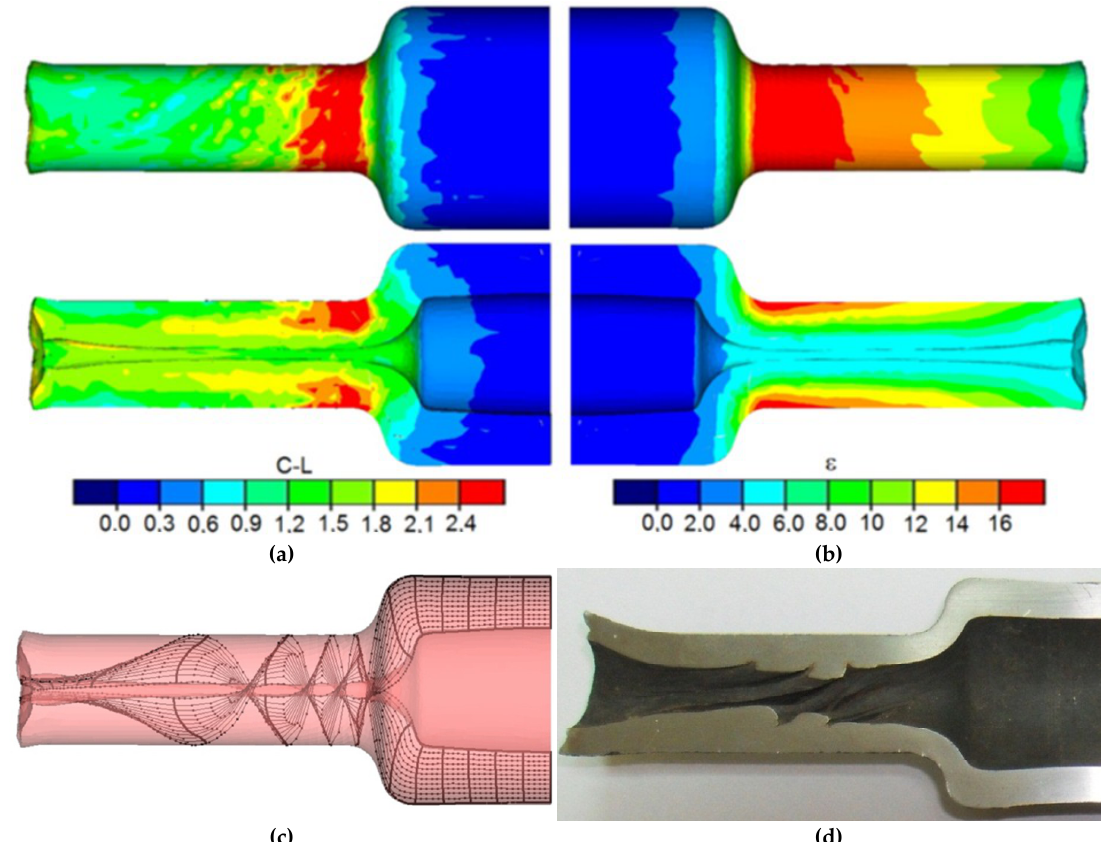
Figure 8. Finite element method (FEM)-determined shape of the end step of the forging, compressed with the parameters : t o /D = 0.21;  = 2.1; v/n = 6 mm/rotation: ( a ) distribution of the damage criterion with the parameters: t o / D = 0.21; δ = 2.1; v / n = 6 mm / rotation: ( a ) distribution of the damage according to Cockcroft–Latham, ( b ) effective strain distribution, ( c ) twisting of the cross-section of the forging, and ( d ) axial section of the forging of the obtained during laboratory testing.